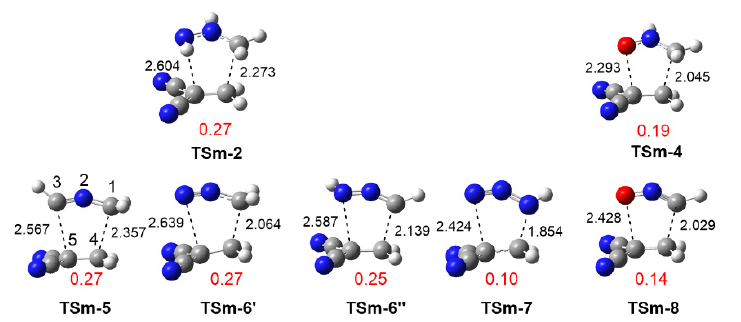
Figure 6. MPWB1K/6-311G(d,p) gas-phase optimized geometries of the TSs associated with the meta regioisomeric path of the 32CA reactions between TACs 1–4 , 6 , 7 and DCE 10 . Distances are given in angstroms, Å, while the GEDT values computed at the TAC framework, in red, are given in number of electrons, e.